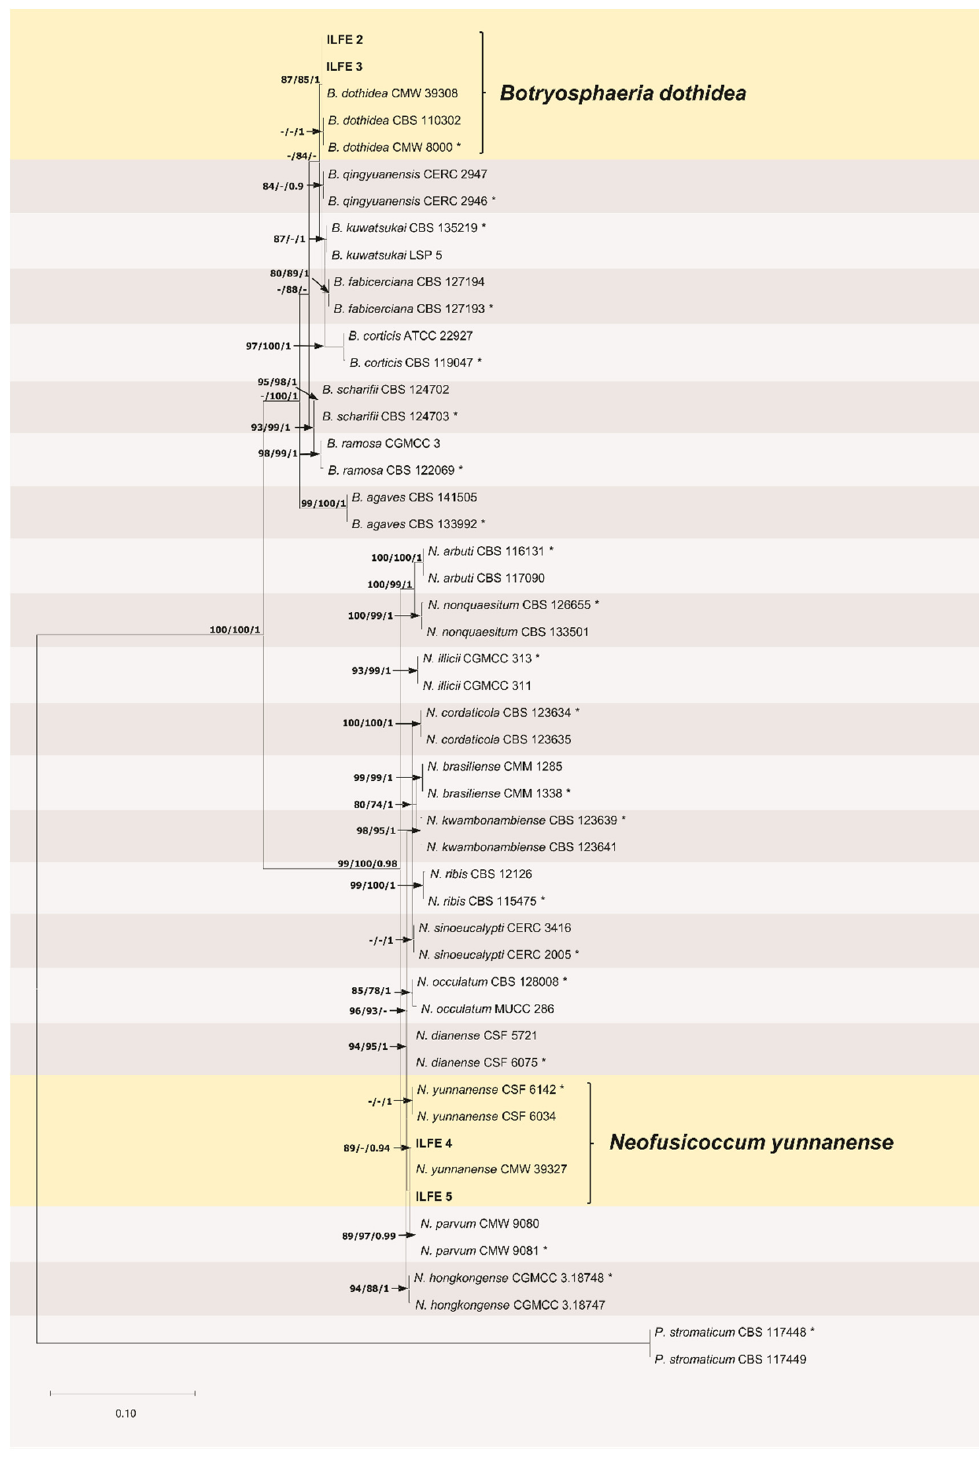
Figure 3. Phylogenetic tree generated from a maximum likelyhood analyses (ML) based on a concatenated alignment of ITS, tef 1- α and TUB2 sequences data showing the position of Botryosphaeria dothidea and Neofusicoccum yunannense in relation to their closely related species. ML and MP bootstrap support values greater than 70% and Bayesian posterior probability values (PP) greater than 0.90 are indicated at the tree nodes (ML/MP/PP). Clades corresponding to N. yunnanense and B. dothidea are highlighted. The type strains are marked with an asterisk and isolates obtained in this study are shown in bold. Pseudofisicoccum stromaticum (CBS 117448 and CMW 117449) was included as an outgroup. Scale bar indicates expected number of substitutions per site.